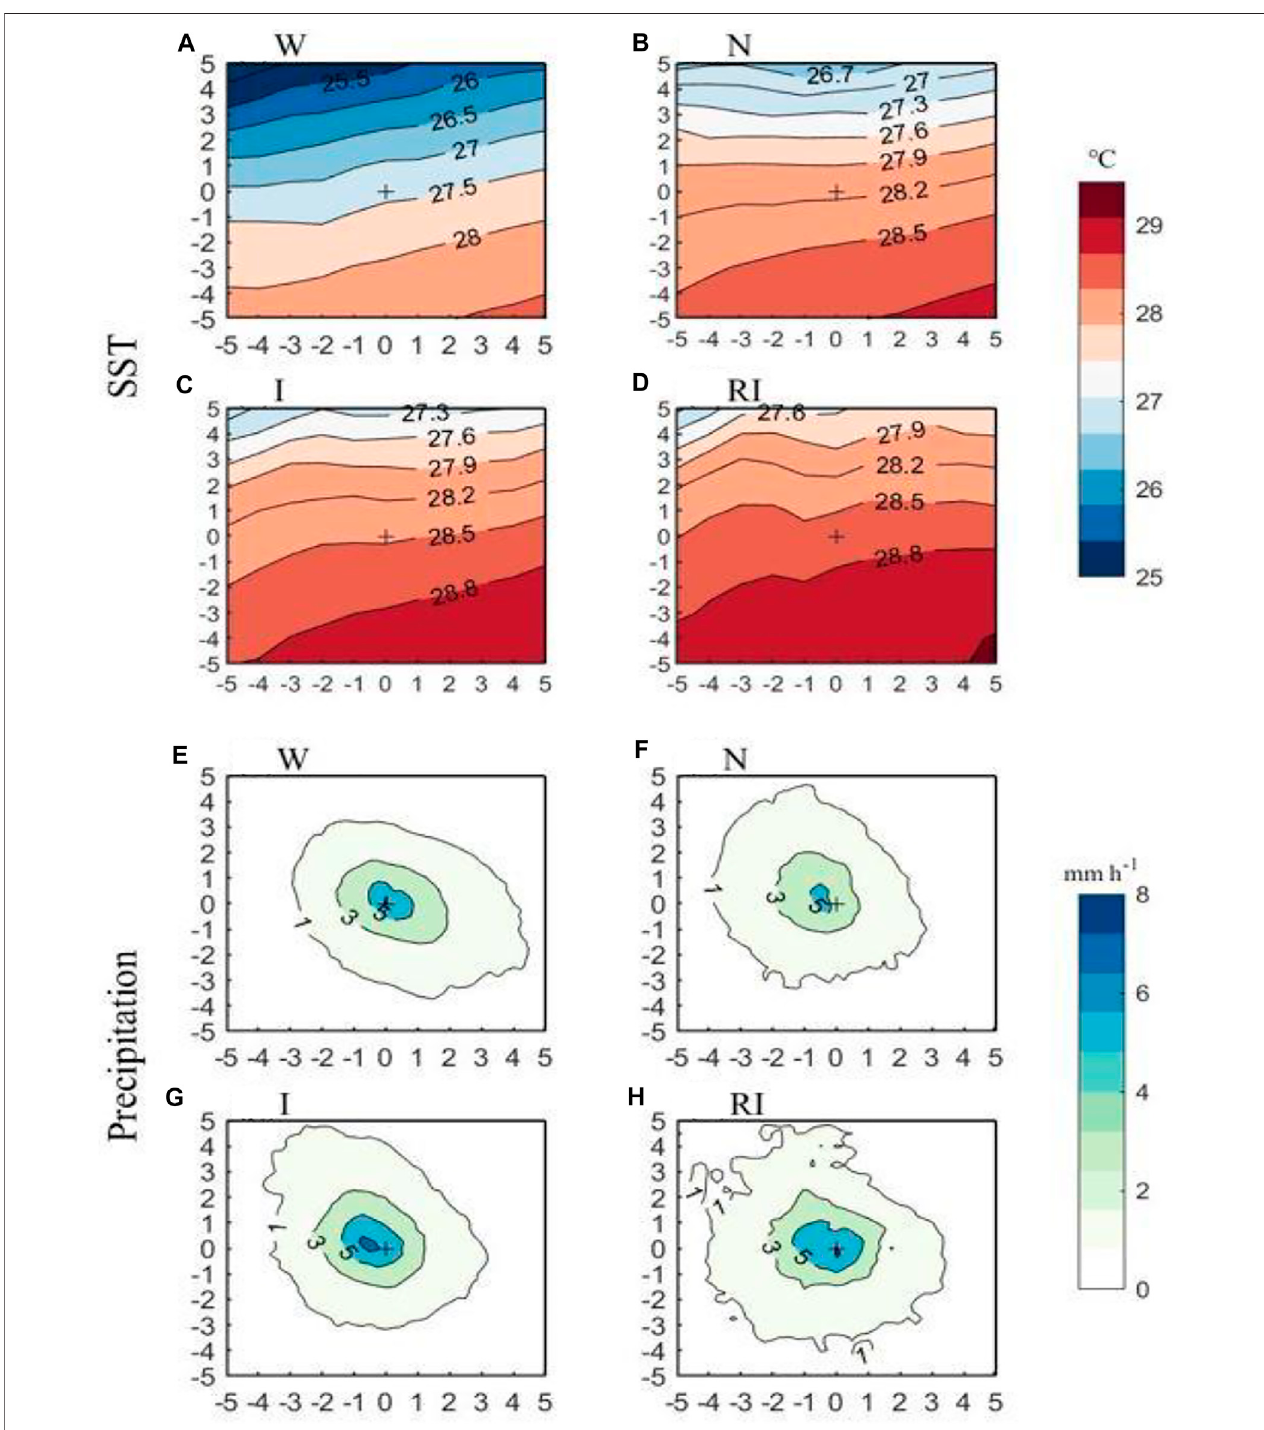
FIGURE 8 | As in Figure7 , but for (A – D) sea surface temperature (SST) in ° C and (E – H) precipitation rate in mm h − 1 .